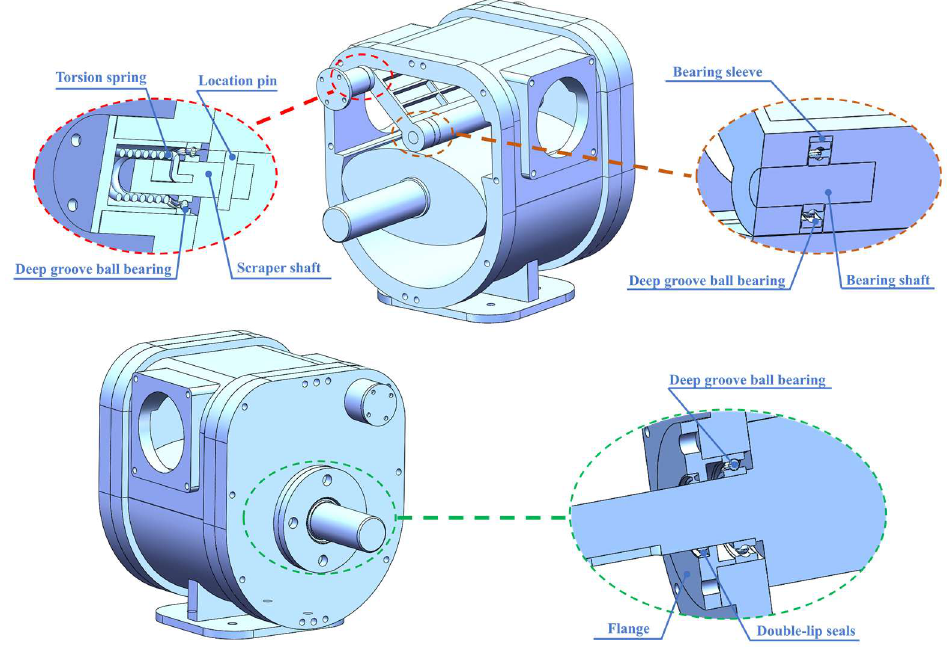
Figure 2. Detail of the pump part of the structure.